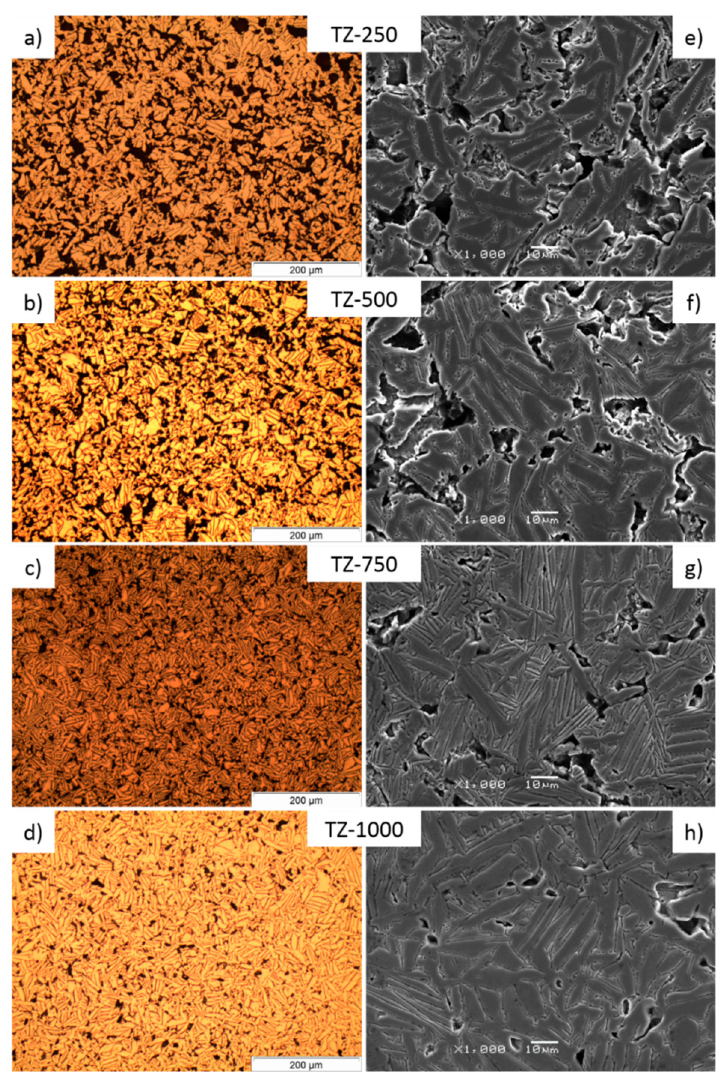
Figure 3. Optical micrographs ( a – d ) and SEM micrographs ( e – h ) of Ti–35Zr (wt.%) for di ff erent pressure during cold isostatic pressuring of 250 MPa ( a , e ), 500 MPa ( b , f ), 750 MPa ( c , g ) and 1000 MPa ( d , h